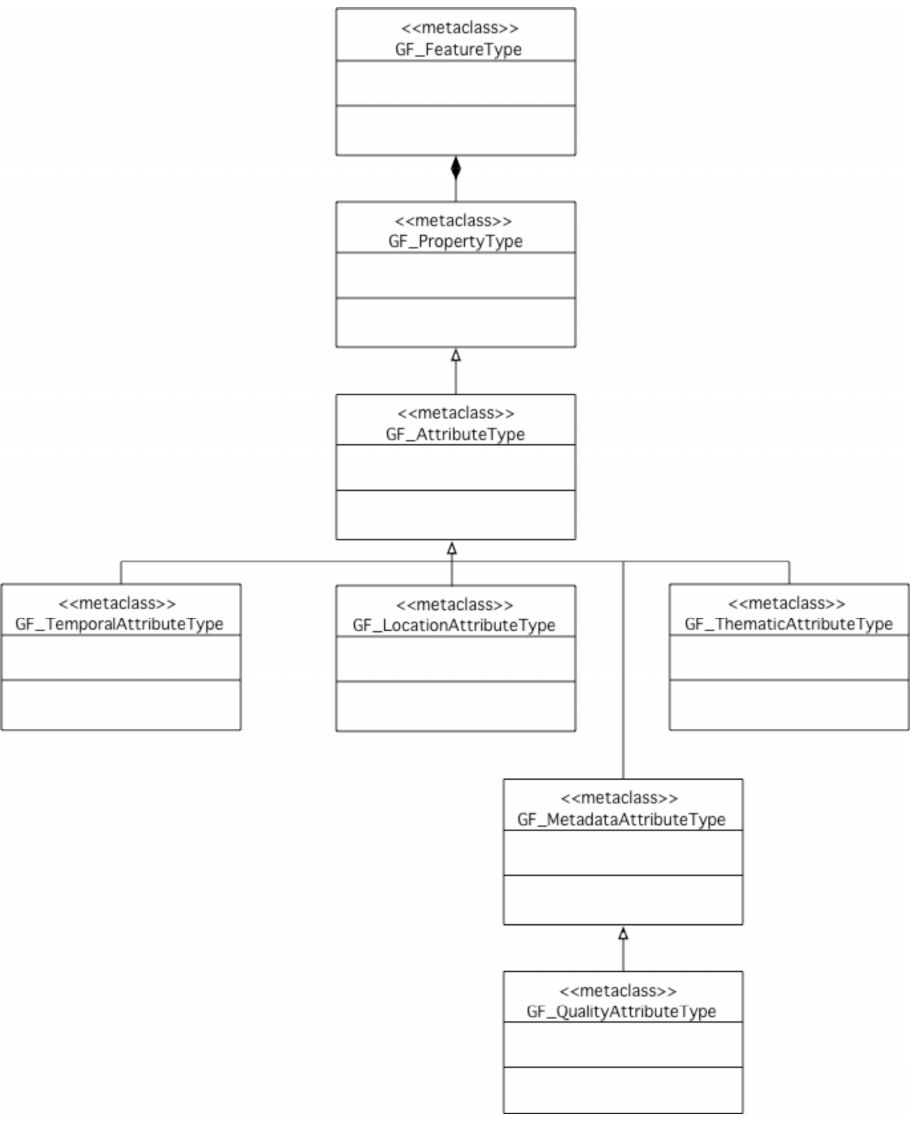
Figure 2. Attributes of ISO 19109 feature types, with an emphasis on the route to metadata-relevant subclasses. Feature metadata instances are catered for by GF_QualityAttributeType’s dependency on the ISO 19115 entity MD_Metadata. (Subset taken from ISO